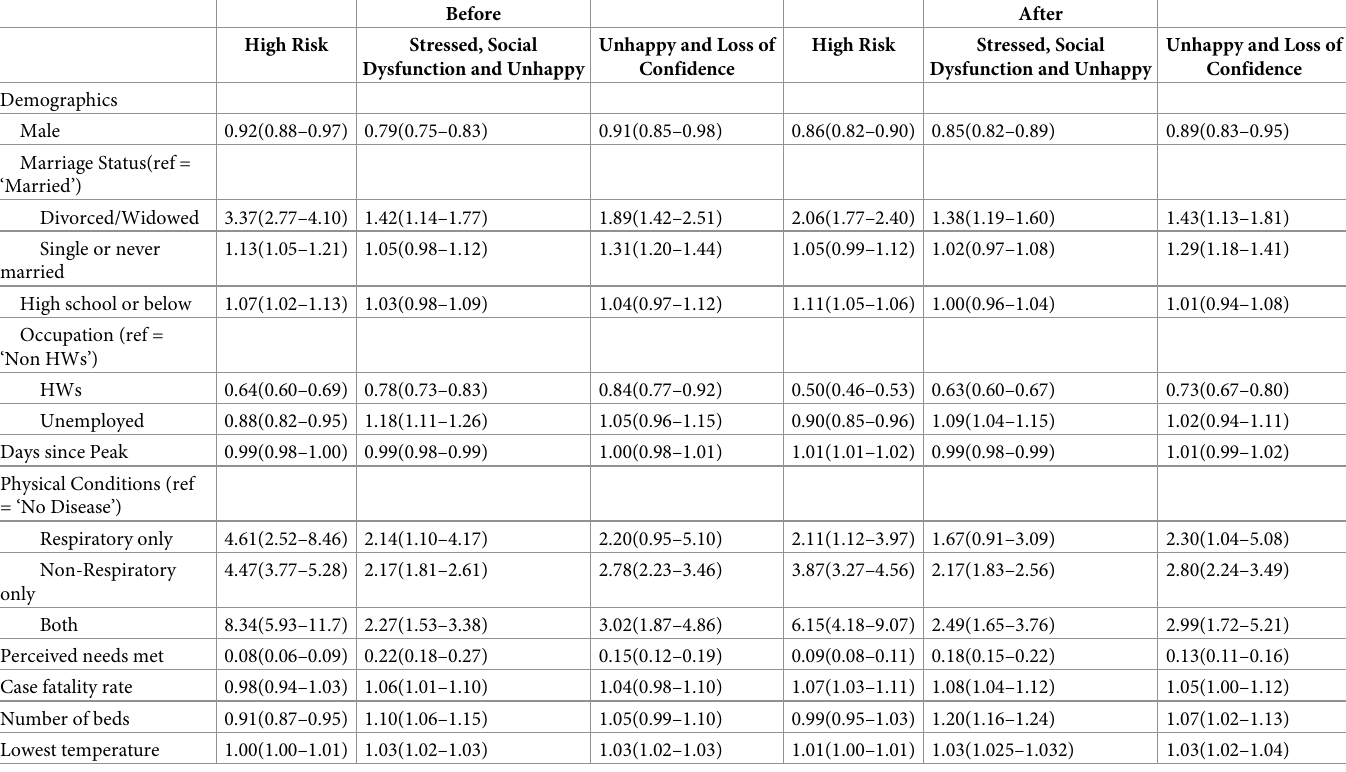
Table 4. Odds ratios (95% CI) from fitted multinomial logistic regression predicting mental health profiles.